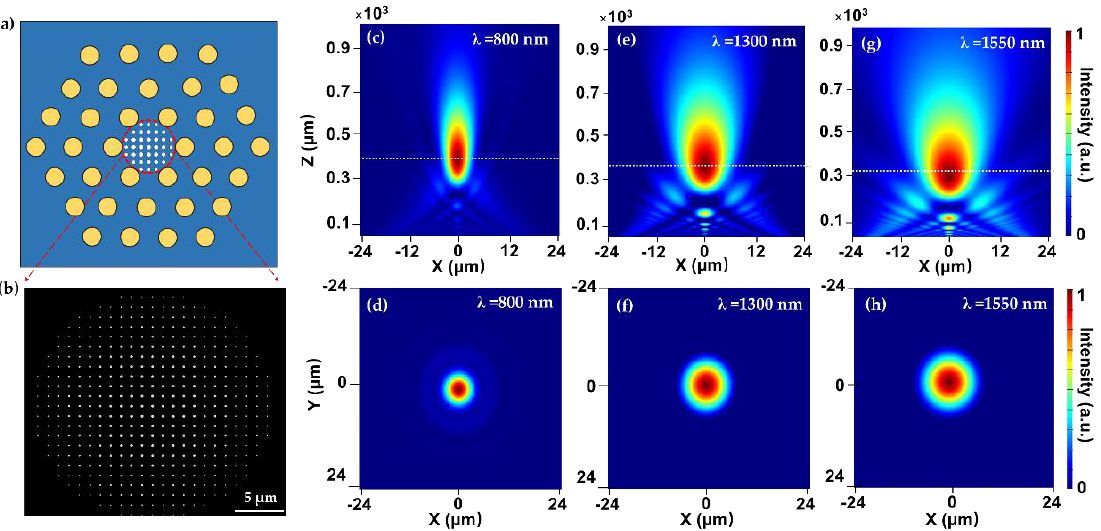
Figure 3. ( a , b ) Schematic of all-glass PCF metalens. Normalized intensity distribution of focal spots Figure 3. ( a,b ) Schematic of all-glass PCF metalens. Normalized intensity distribution of focal at x-z and x-y plane upon incident beam at the wavelength of ( c , d ) 800 nm, ( e , f ) 1300 nm, and ( g , h ) spots at x-z and x-y plane upon incident beam at the wavelength of ( c, d ) 800 nm, ( elf ) 1300 nm, 1550 nm. Reprinted with permission from Ref. [46]. Copyright 2021 and ( g,h ) 1550 nm. Reprinted with permission from Ref. [46] . Copyright 2021, MDPI. Figure 3. ( a,b ) Schematic of all-glass PCF metalens. Normalized intensity distribution of focal 228 spots at x-z and x-y plane upon incident beam at the wavelength of ( c, d ) 800 nm, ( elf ) 1300 nm, 229 Zhao et al. replaced the air-holes constituting PCF cladding with fluorine-doped 231 and ( g,h ) 1550 nm. Reprinted with permission from Ref. [46] . Copyright 2021, MDPI. 230 glass rods to reduce the refractive index between the core and cladding, which increased the single-mode operation regime. The designed LAM-PCF for loading the dielectric Zhao et al. replaced the air-holes constituting PCF cladding with fluorine-doped 231 glass rods to reduce the refractive index between the core and cladding, which increased 232 the single-mode operation regime. The designed LAM-PCF for loading the dielectric 233